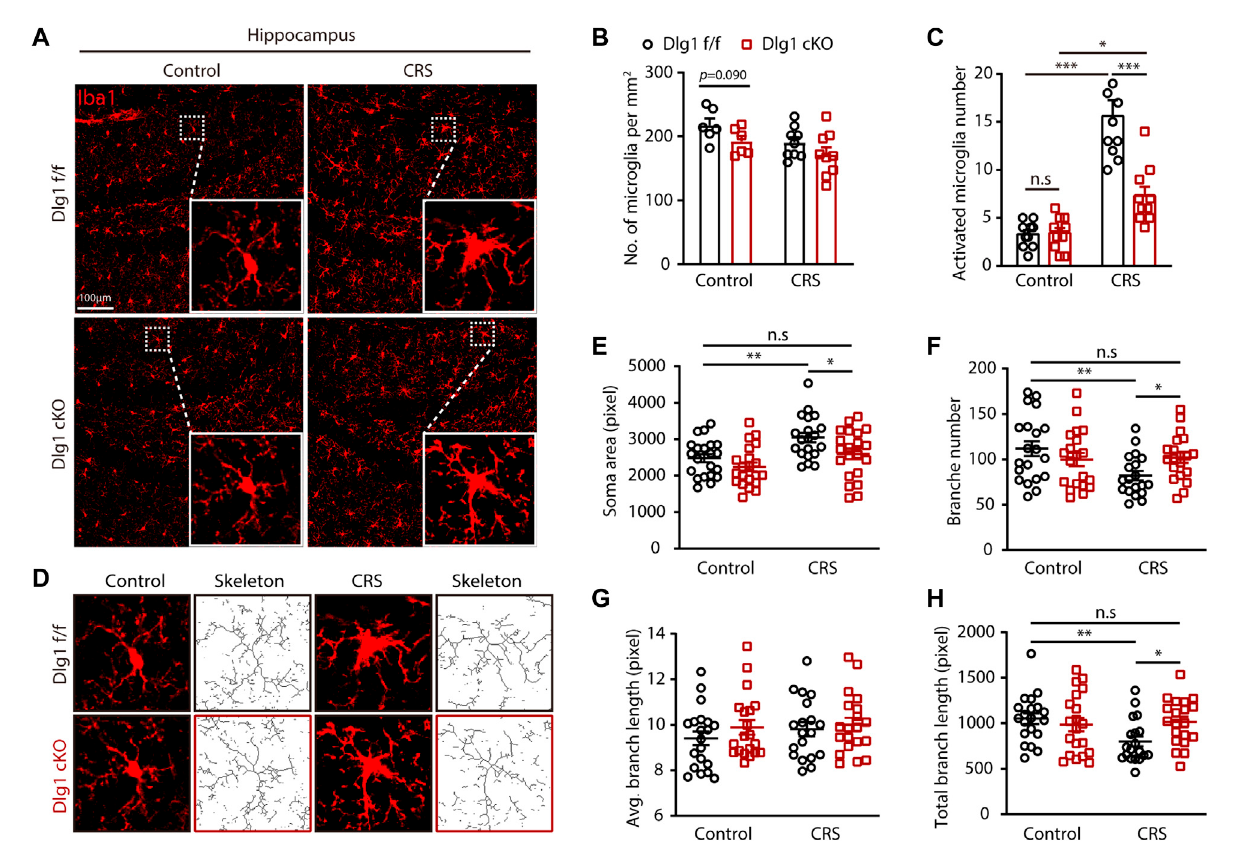
FIGURE 3 Microglial Dlg1 deletion reverses microglia overactive state found in chronic restraint stressed mice. (A) Immuno fl uorescence staining for Iba1 of Dlg1 f/f and cKO mice brain slices with and without CRS exposure. (B) Quanti fi cation of microglia density in indicated four groups. (C) Quanti fi cation of thenumberofactivatedmicrogliainasingle fi eldofview. (D) Representativeimagesofmicroglia(Iba1immunostaining,red)andskeletonizedmicrogliaof Dlg1 f/fandcKOmicebrainsliceswithandwithoutCRSexposure. (E,F) Quantitativeanalysisofmicroglialsomaarea (E) ,branchnumber (F) ,average branch length (G) , and total branch length (H) . Data are presented as the mean ± SEM; * p < 0.05, ** p < 0.01, *** p < 0.001, two-way ANOVA with Turkey ’ s multiple comparisons